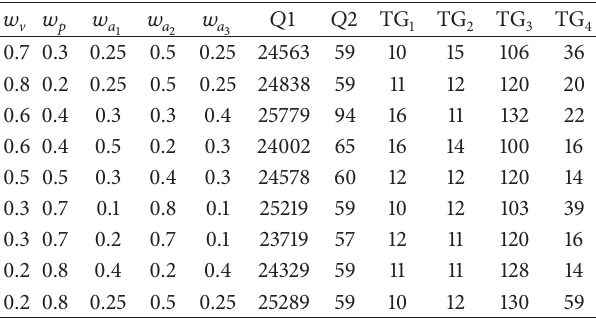
Table 2: Final outputs of the GA.